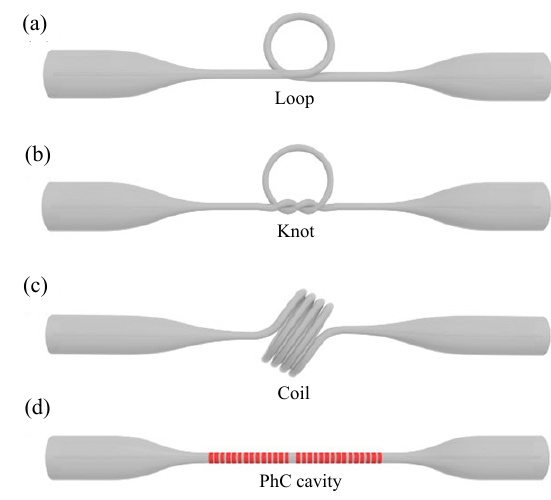
Fig. 5 Schematic of typical microfiber resonators: (a) microfiber loop resonator, (b) microfiber knot resonator, (c) microfiber coil resonator, and (d) microfiber PhC